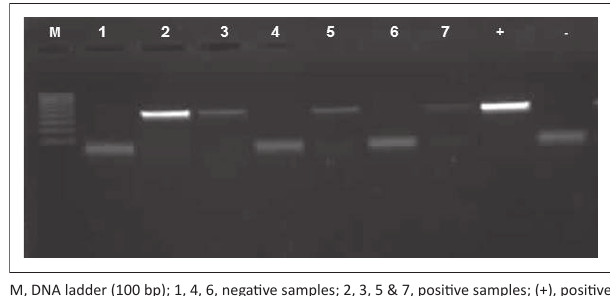
M, DNA ladder (100 bp); 1, 4, 6, negative samples; 2, 3, 5 & 7, positive samples; (+), positive control ( Rickettsia helvetica ); (-), negative control (Double distilled water). FIGURE 3: Gel electrophoresis of Rickettsia species polymerase chain reaction. Amplified polymerase chain reaction product with amplicon size of 401